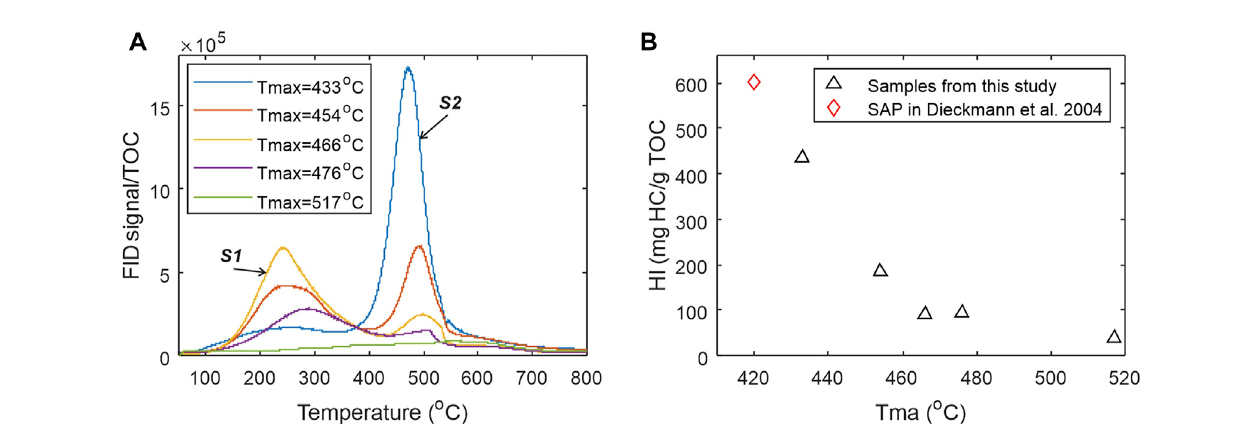
FIGURE 2 (A) Hydrocarbon pyrograms of the fi ve shale samples from EGA pyrolyzer showing general trends of decreasing hydrocarbon generation potential represented by S2 peaks and increasing free hydrocarbon represented by S1 peaks with increasing thermal maturity represented by Tmax. Higher maturity samplesdonothavelargerS1peaksduetoevaporativelossofgaseousandvolatilehydrocarbonsandtheexpulsionofalargepartofgeneratedhydrocarbons out of the source rocks prior to coring; (B) Cross-plot of Tmax-HI data from Rock-Eval analysis showing the trajectory of thermal decomposition for kerogen in Duvernay